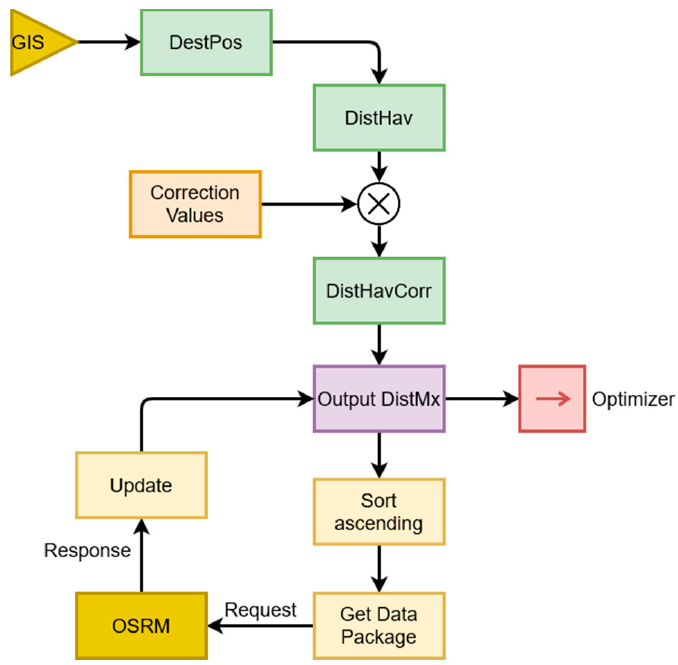
Figure 8. “Smart” geopositioning updating of the distance matrix.